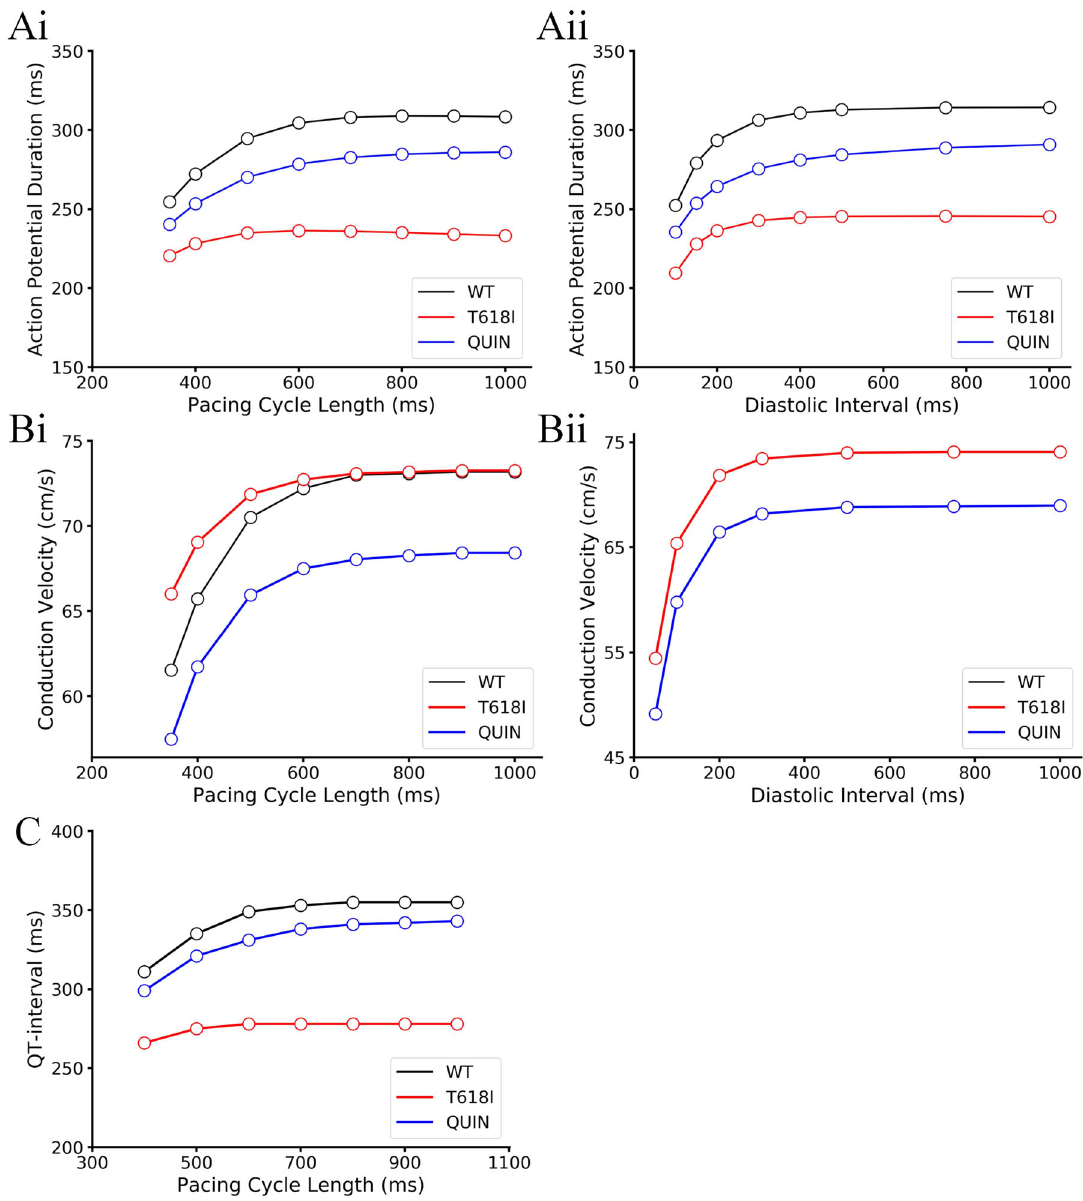
Fig. 9 Simulation results of APD and CV restitution curves and the rate adaption curves of QT interval under wild-type, T618I mutation, and quinidine conditions. A APD restitution curves obtained from the S1 – S2 protocol ( Ai ) and the dynamic protocol ( Aii ), where APDs were plotted against PCL and DI, respectively. B CV restitution curves obtained from the S1 – S2 protocol ( Bi ) and the dynamic protocol ( Bii ). C The rate adaption curves of QT